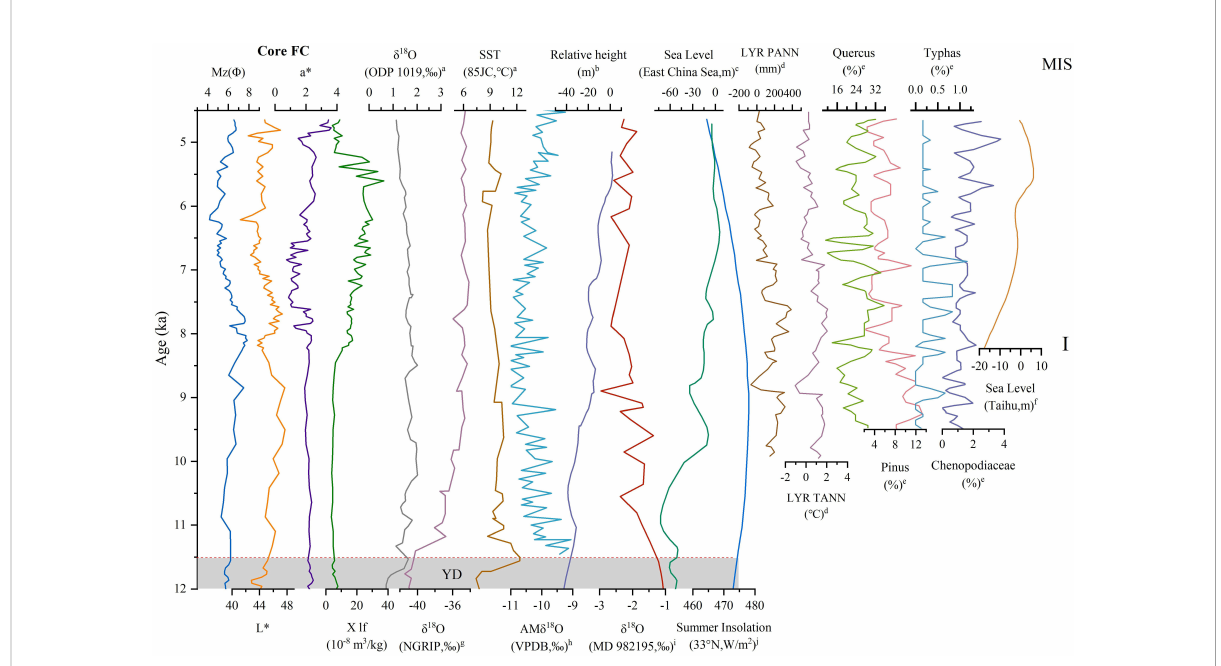
FIGURE 9 Response of substitutive indexes of borehole sediments from FC borehole during the Holocene to climate and sea level changes records. The geological record curves separately from: Praetorius et al., 2020 (a); Zhu et al., 2003 (b); Zheng, 2018 (c); Li, 2017 (d); Wang et al., 2008 (e); Yang and Xie, 1984 (f); Walczak et al., 2020 (g); Cheng et al., 2016 (h); Kawahata et al., 2006 (i); Zhang, 2011